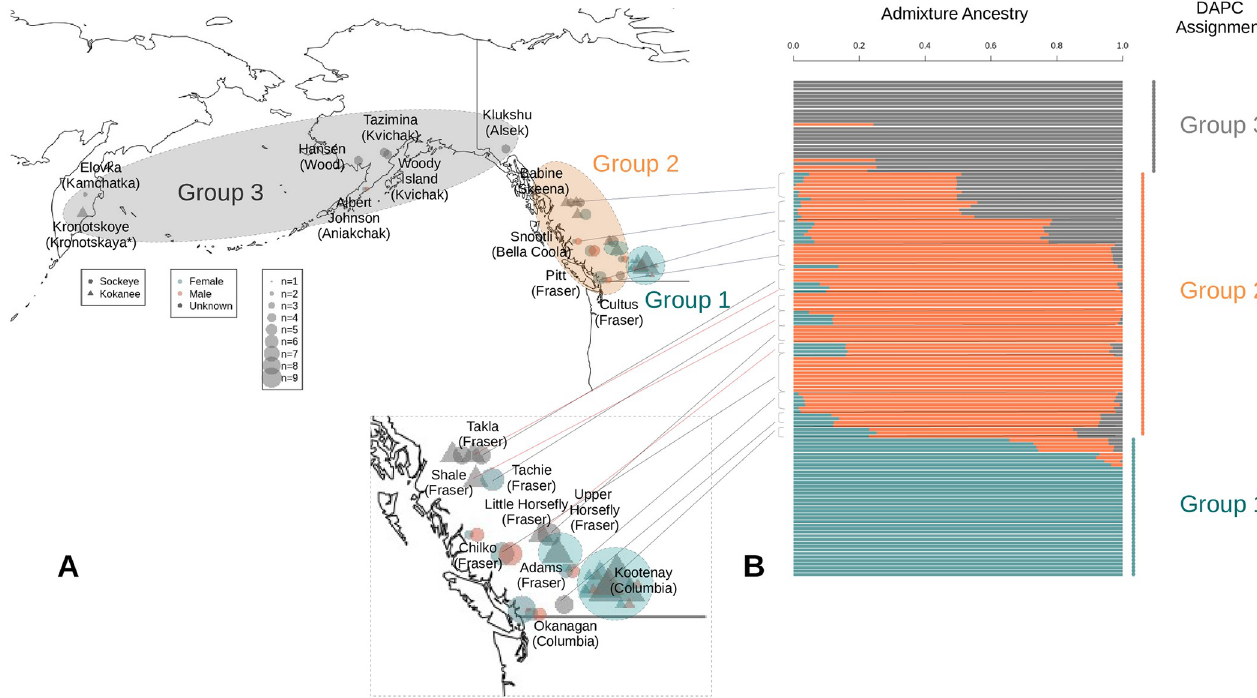
Fig 3. Population stratification relative to location. This figure shows the map of the sample sites and the admixture and DAPC clustering analyses. A) The sample site locations with the DAPC assignments overlaid. Specific locations from group 2 are shown with lines. Red lines represent kokanee samples. Only group 2 and 3 body of water names (with drainage in parentheses) are displayed for clarity. The insert shows greater detail of Skeena, Bella Coola, Fraser, and Columbia River bodies of water and is linked by lines to Fig 3B. B) An admixture analysis with k = 3. The colours are consistent with the DAPC analysis and DAPC groups are shown. From the DAPC group 2, there appears to be differentiation between proximal sockeye and kokanee samples based on the admixture ancestry values (in the Fraser River drainage). There also appears to be a latitudinal cline of the gray admixture ancestry values for some sites of DAPC groups 2 and